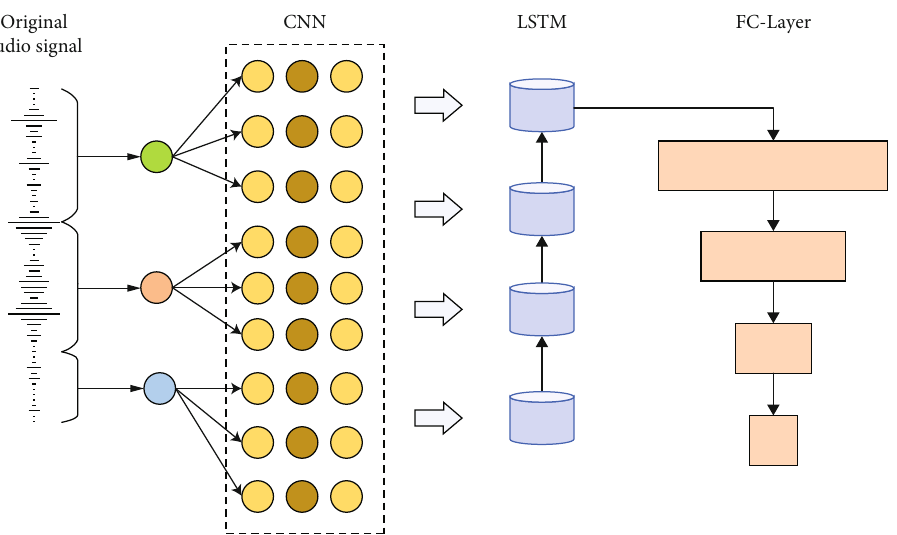
Figure 1: Block diagram of the violence audio detection system based on the original audio